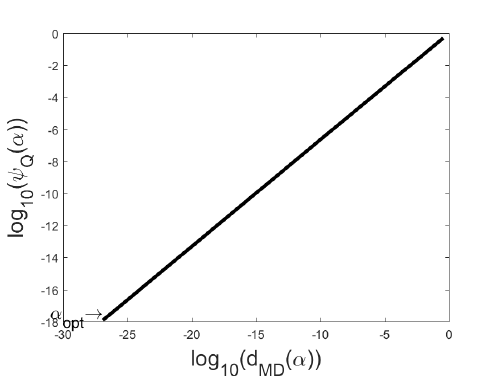
Figure 8. Q-curve in